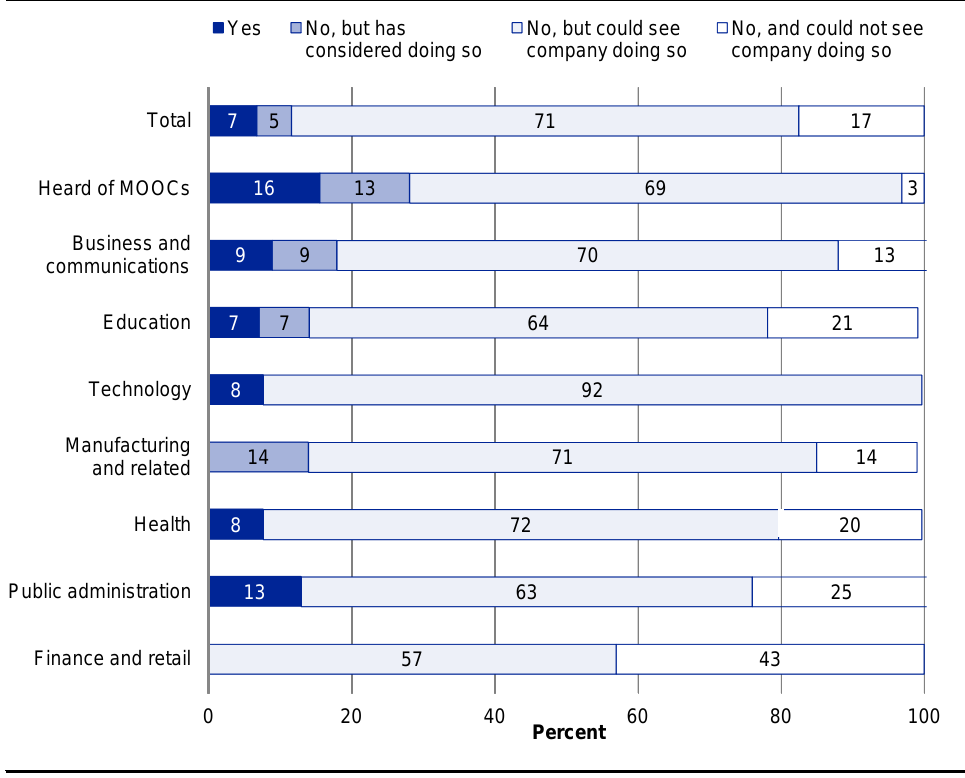
Figure 6. Percentage distribution of organizations that had used, considered using, or were open to using MOOCs for professional development: among all respondents, those that had heard of MOOCs prior to the survey, and by industry.